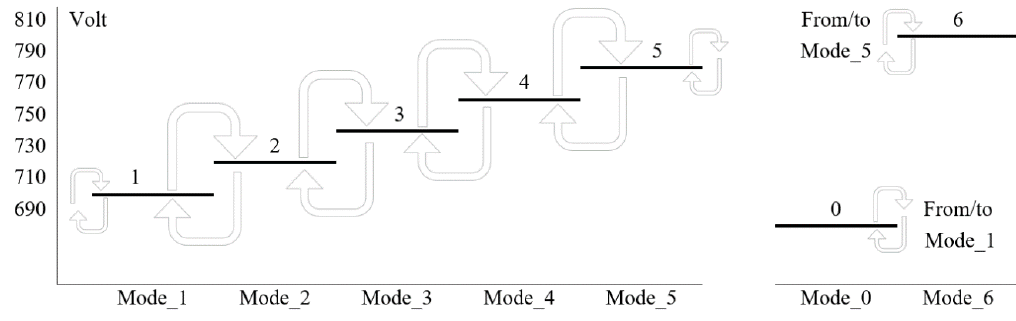
Figure 3. The grid-connected nanogrid for home application for PV-batteries hybrid systems.